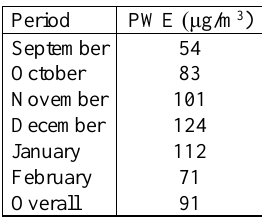
Table 5. Total PWE of the whole period and all